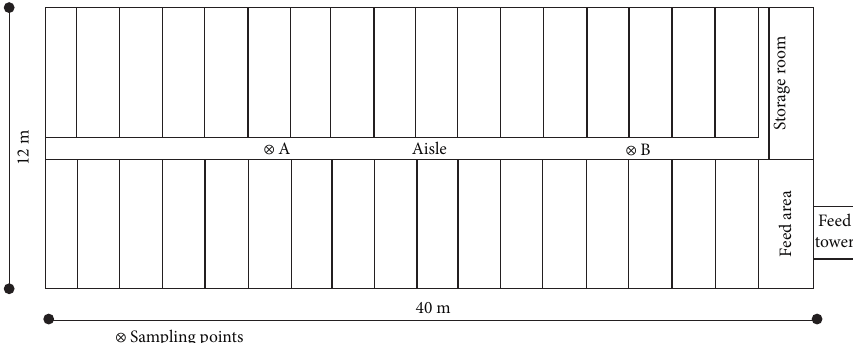
Figure 1: Schematic layout of the fattening swine barn.